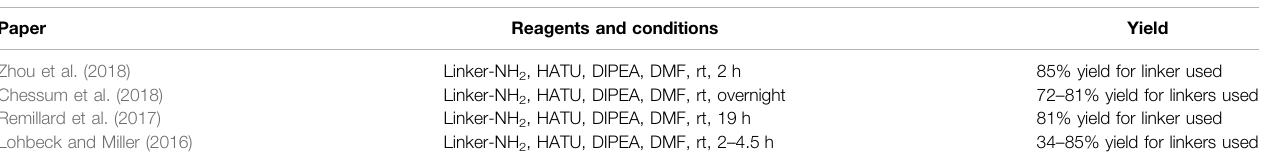
TABLE 4 | Reagents, conditions, and yields for the conversion of 53 to 54 ( Scheme 12 , step c). Paper Reagents and conditions